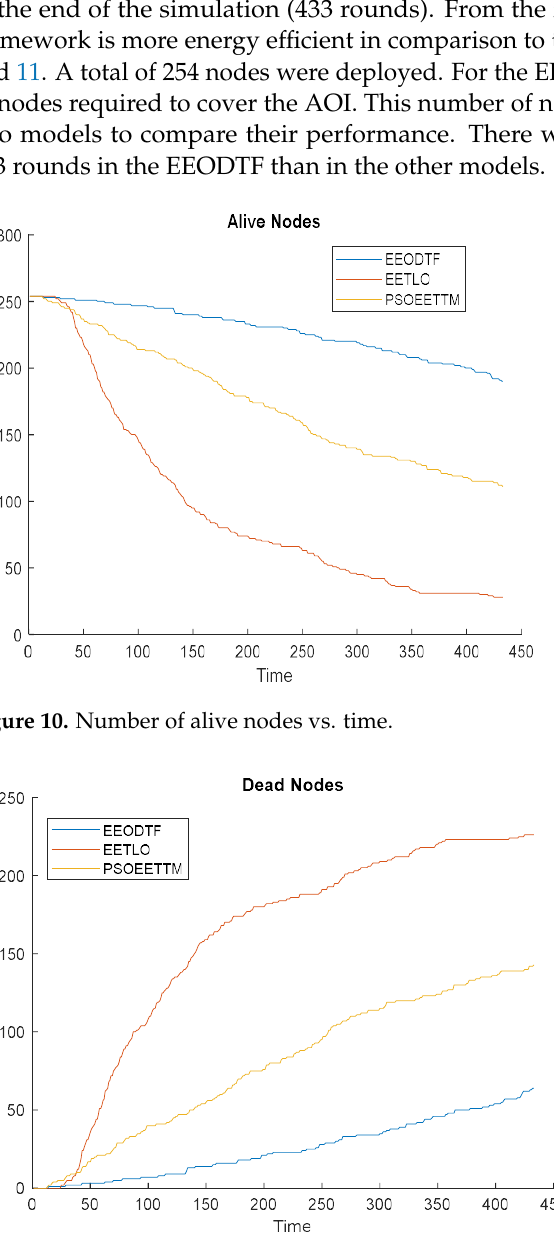
Figure 12. Residual energy of network vs. time. The time complexity of algorithm 1 is O(nm), where n is the number of steps travelled by the object at time t and m is the number of nodes deployed in the network. 0